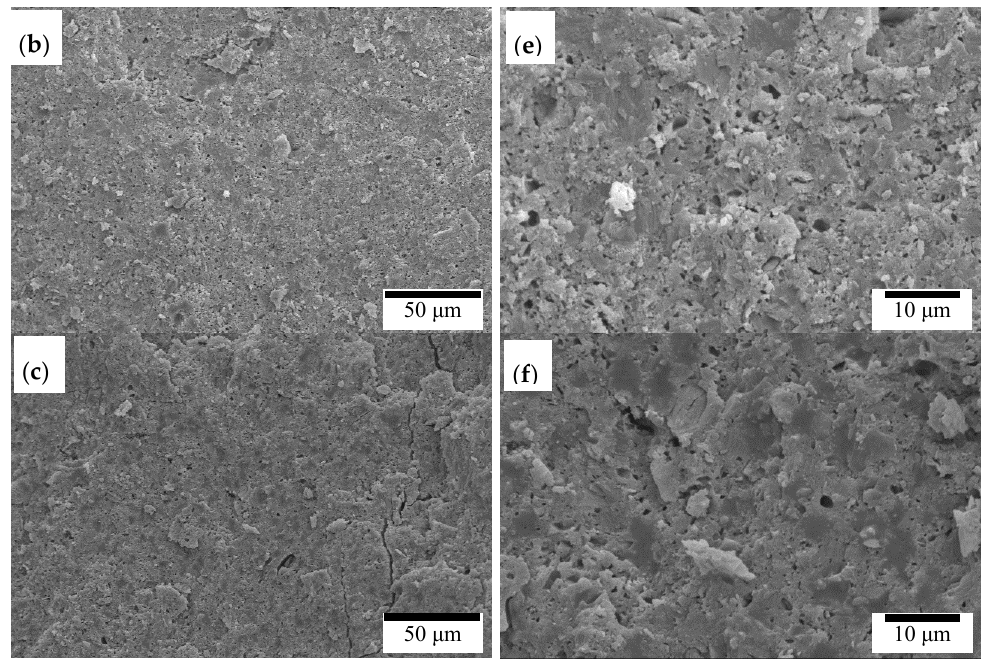
Figure 3. SEM observation of CPC ( a ) 500× ( d ) 2000×; CPC/H4 ( b ) 500× ( e ) 2000×; and CPC/H8 ( c ) 500× ( f ) 2000×.